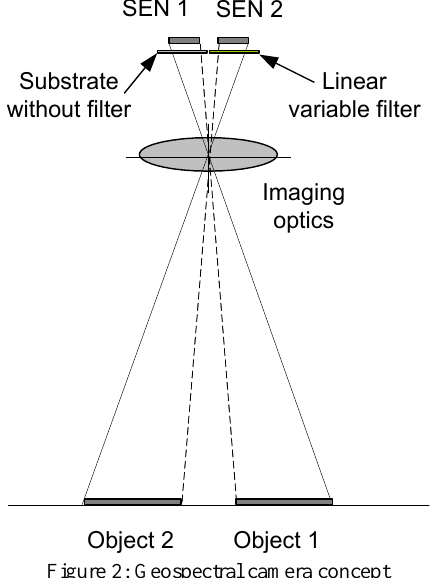
Figure 2: Geospectral camera